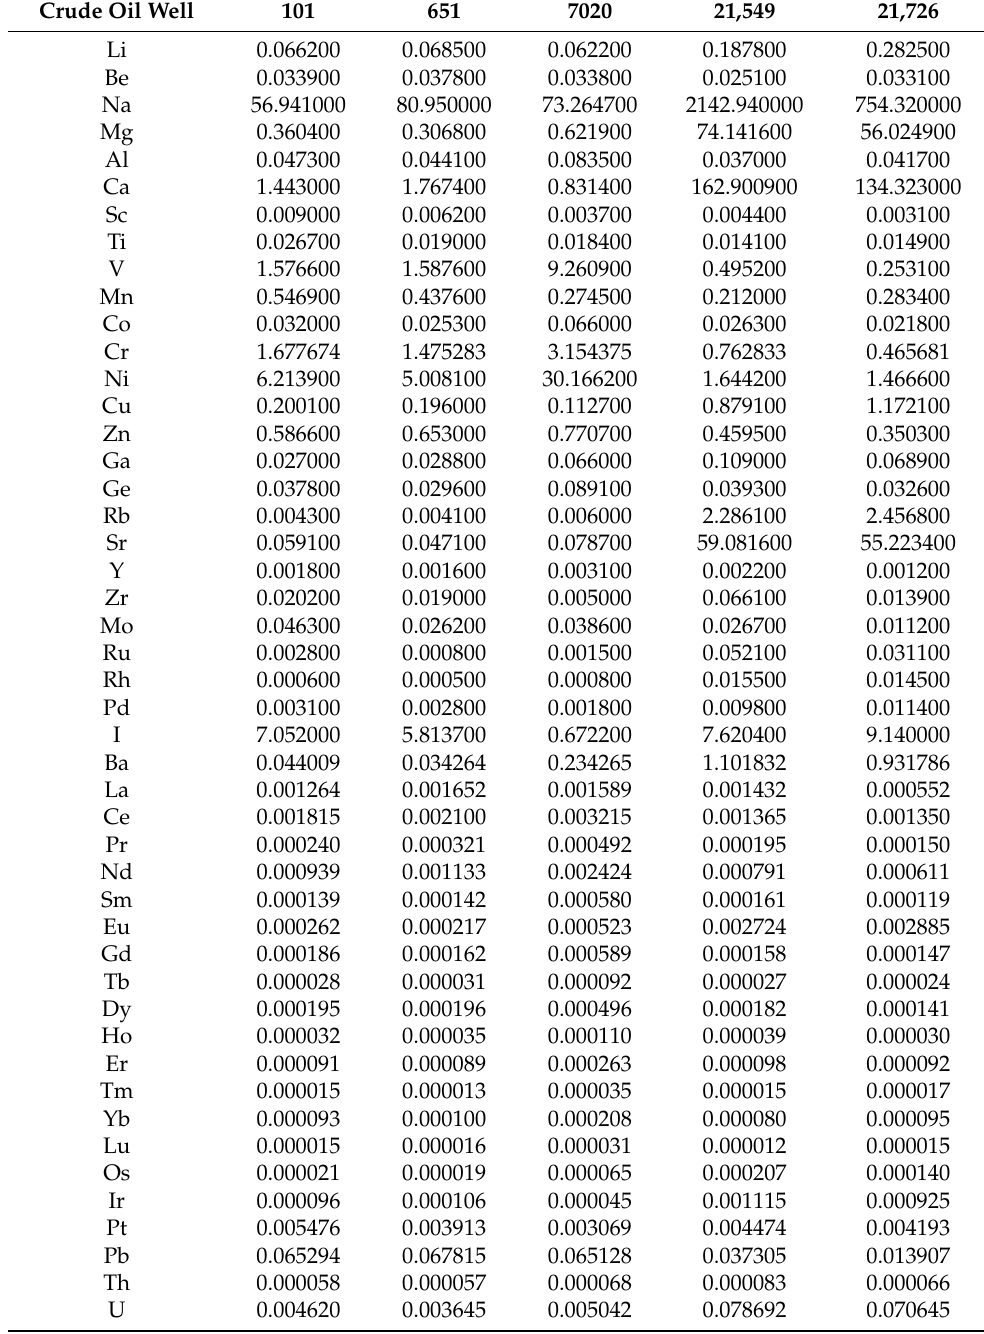
Table 4. Results of ICP-MS (in ppm) for crude oil of Berezovskaya area (Romashkinskoye oil